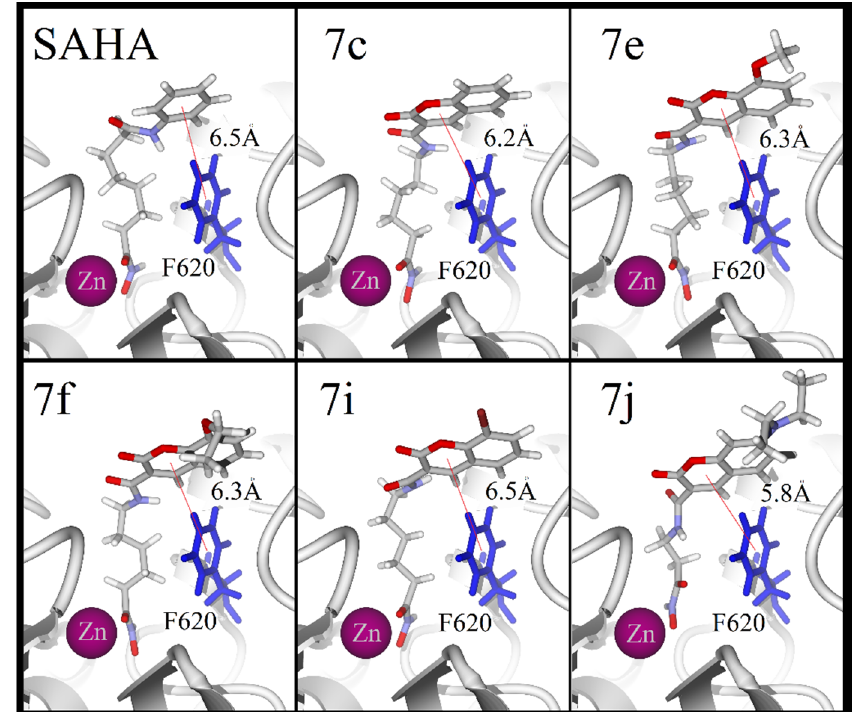
Figure 6. The binding modes for SAHA and compounds 7c , 7e , 7f , 7i and 7j at the active site of HDAC1, according to molecular docking calculations. The ligands are illustrated with a tube model. Oxygen atoms are depicted in red, the bromine atom in dark red, carbon atoms in gray, nitrogen atoms in purple and the zinc atom in pink.